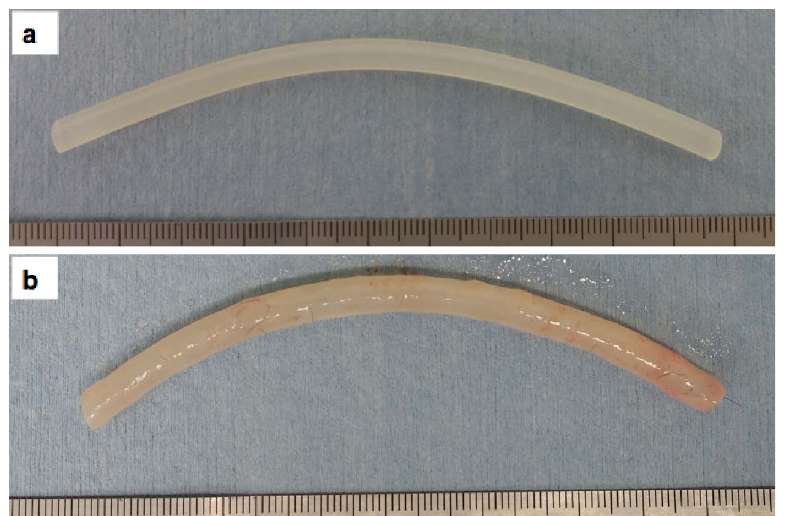
Fig 1. Silicone rod mold (a) and constructed in vivo tissue-engineered vascular graft (b).